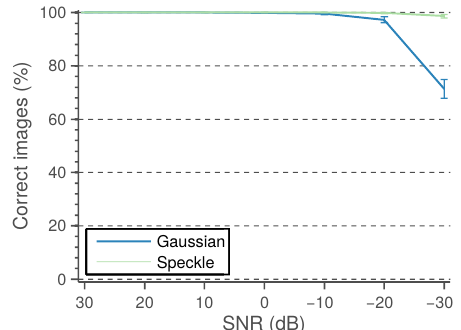
Figure 9. Performance of the candidate lumen detection algorithm as a percentage of images with 80% correct candidates depending on the noise